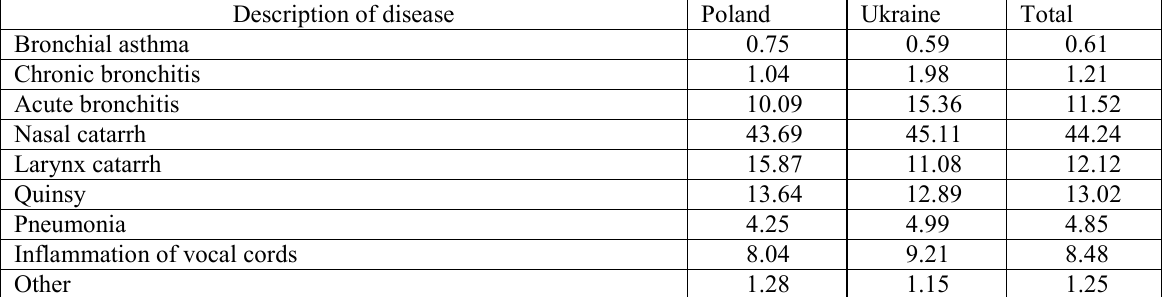
Structure of respiratory system’s morbidity of the tested children (1657 cases per 1091 children)